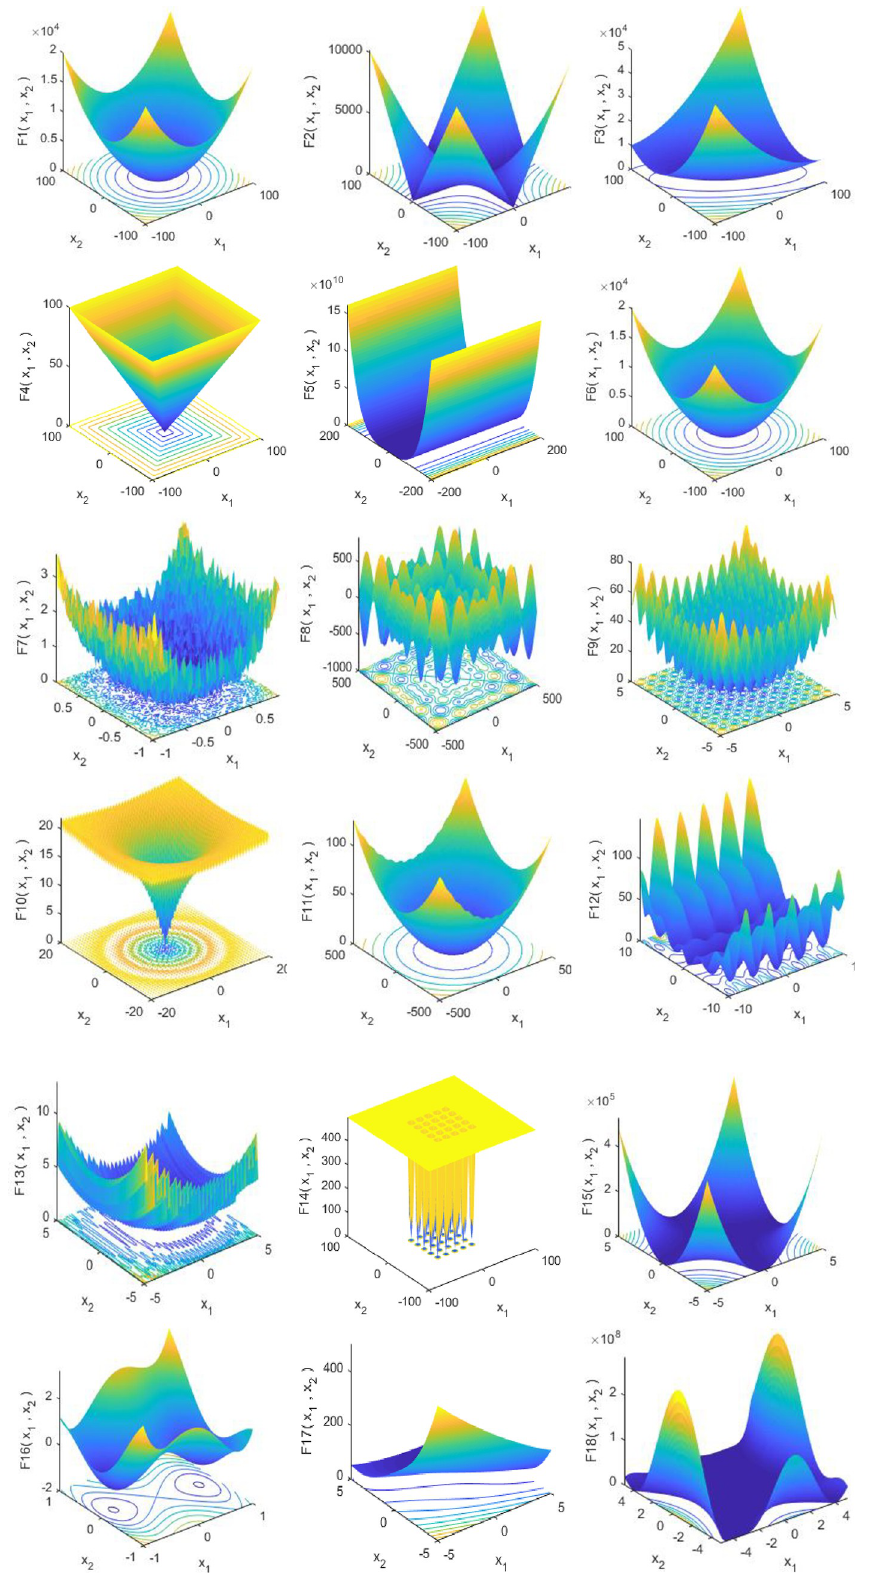
Fig 5. Two-dimensional (2-D) view of the benchmark